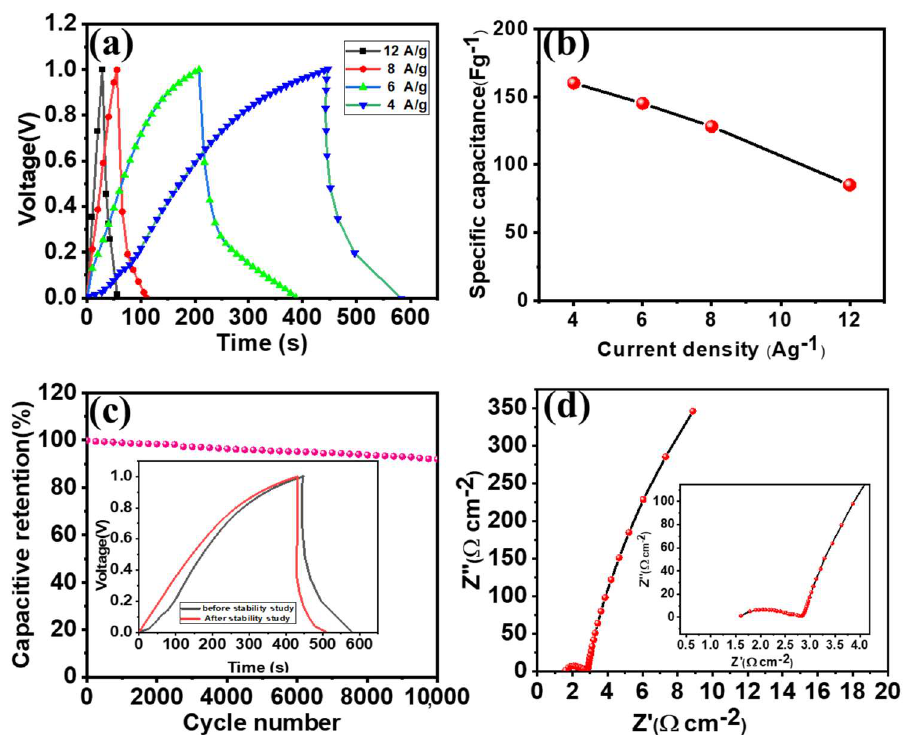
Figure 8. ( a ) GCD curves, ( b ) variation in specific capacitance at different current densities, ( c ) ca- pacitive retention study, and inset show stability study, ( d ) Nyquist plot, and the inset shows the high-frequency region for the Co 3 O 4 -NF//α-Fe 2 O 3 -NF ASC device.